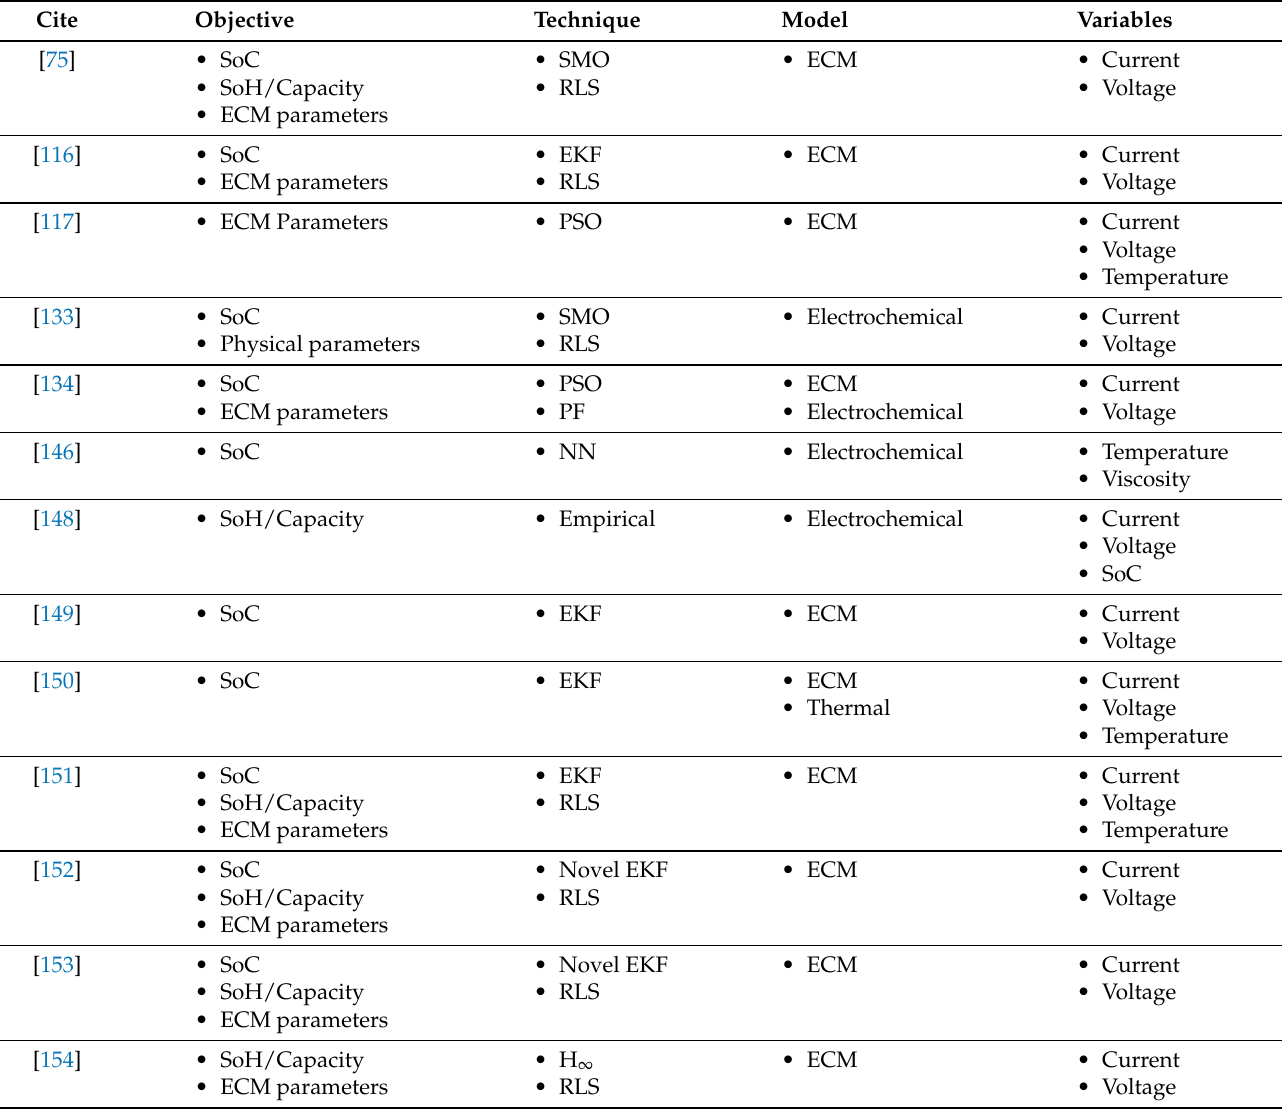
Table 5. Characteristics of each work related to VRFB